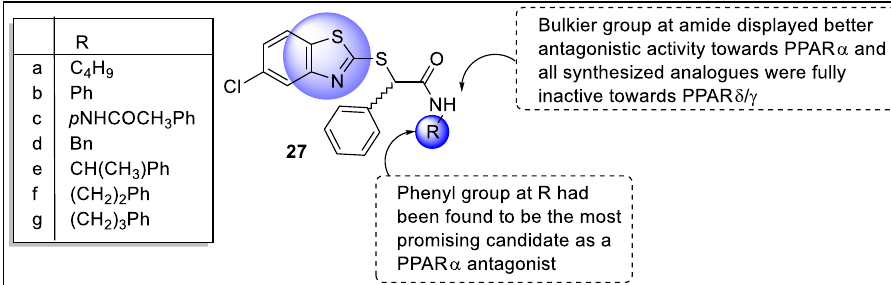
Figure 31. Structural activity relationship of thiazole hybrids ( 27 ) as potent PPAR ligands.